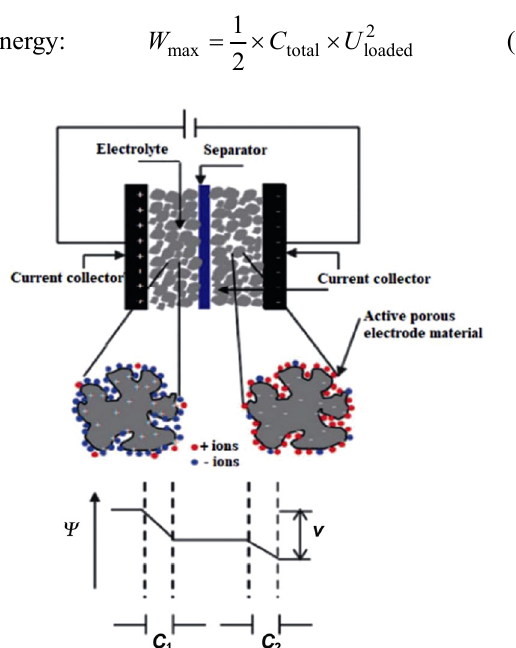
Fig. 26 Schematic of porous electrode materials used in a supercapacitor. Reproduced with permission from